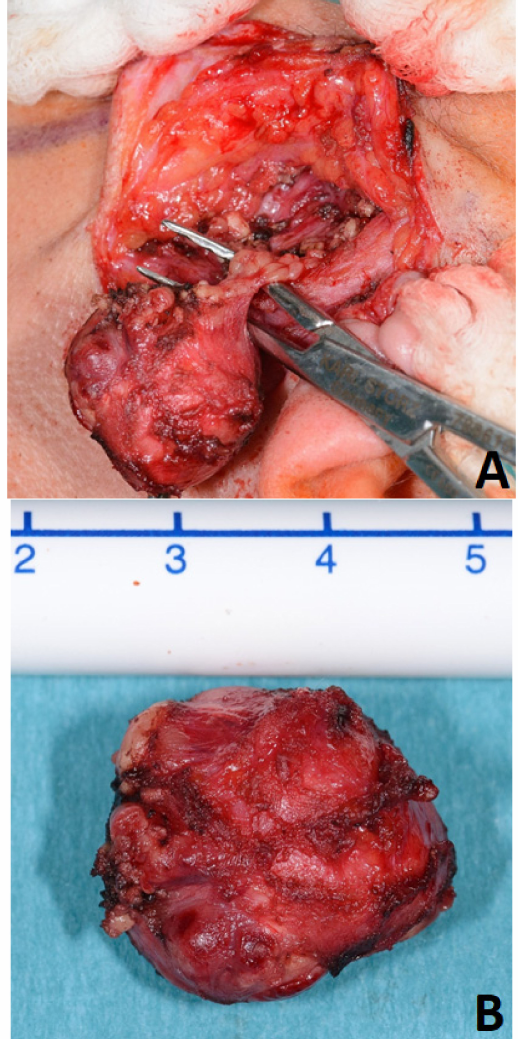
Figure 2. Extracapsular dissection ( A ) of a pleomorphic adenoma of the parotid gland ( B